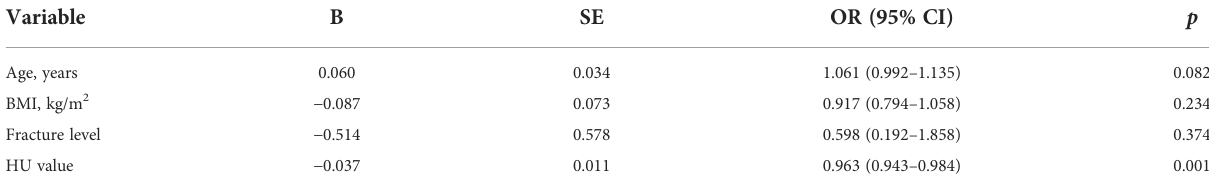
TABLE 2 Multivariable regression analysis for the risk of new VCF.